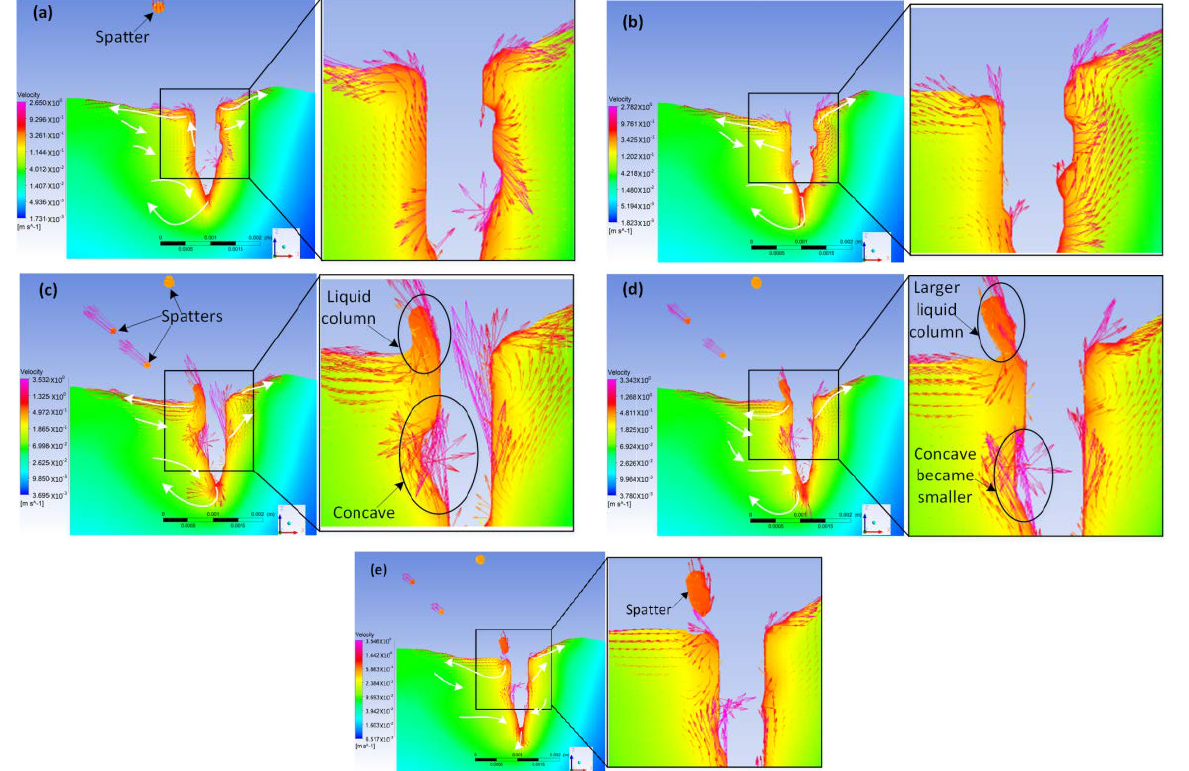
Figure 7. The melt flow behavior in the molten pool with preheating temperature of 300 K (ambient temperature): ( a ) t = 26.4 ms, ( b ) t = 28 ms, ( c ) t = 29 ms, ( d ) t = 29.1 ms, ( e ) t = 29.2 ms.